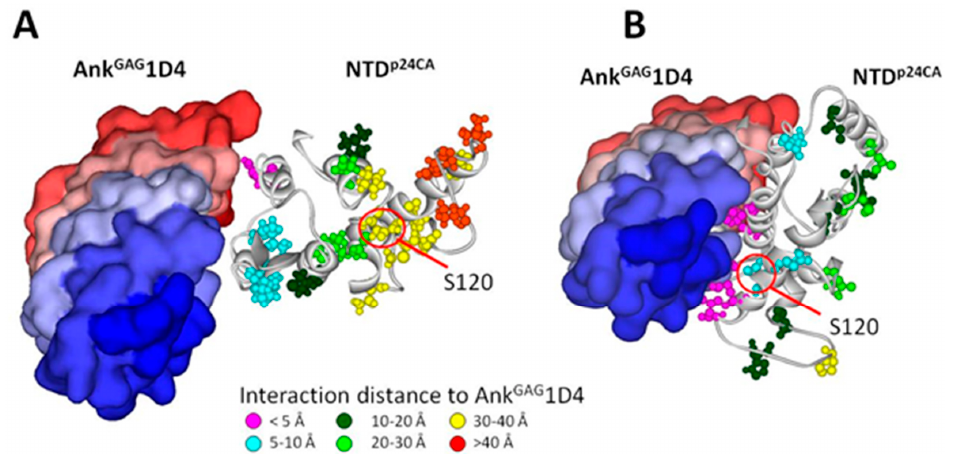
Figure 6. Nineteen amino acids having polymorphic residues present in the docking complexes of Ank GAG 1D4 (PDB code: 4HLL and NTD p24CA (PDB code: 2LF4). Ank GAG 1D4 bound to helix 1 ( A ) Ank GAG 1D4 bound to helix 7 ( B ). The atom style represents the residues on the NTD p24CA (in ribbon style) interacting with Ank GAG 1D4 (surface form). The colour of the atom style indicates the distance between the NTD p24CA residues and Ank GAG 1D4 in which pink, cyan, dark green, light green, yellow, and orange indicate distances at <5 Å, 5–10 Å, 10–20 Å, 20–30 Å, and 30–40 Å, >40 Å, respectively. The variable residue, S120 (40.46%), is outside the binding pocket residues in the case of Ank GAG 1D4 bound to helices 1 and 7 of the NTD.